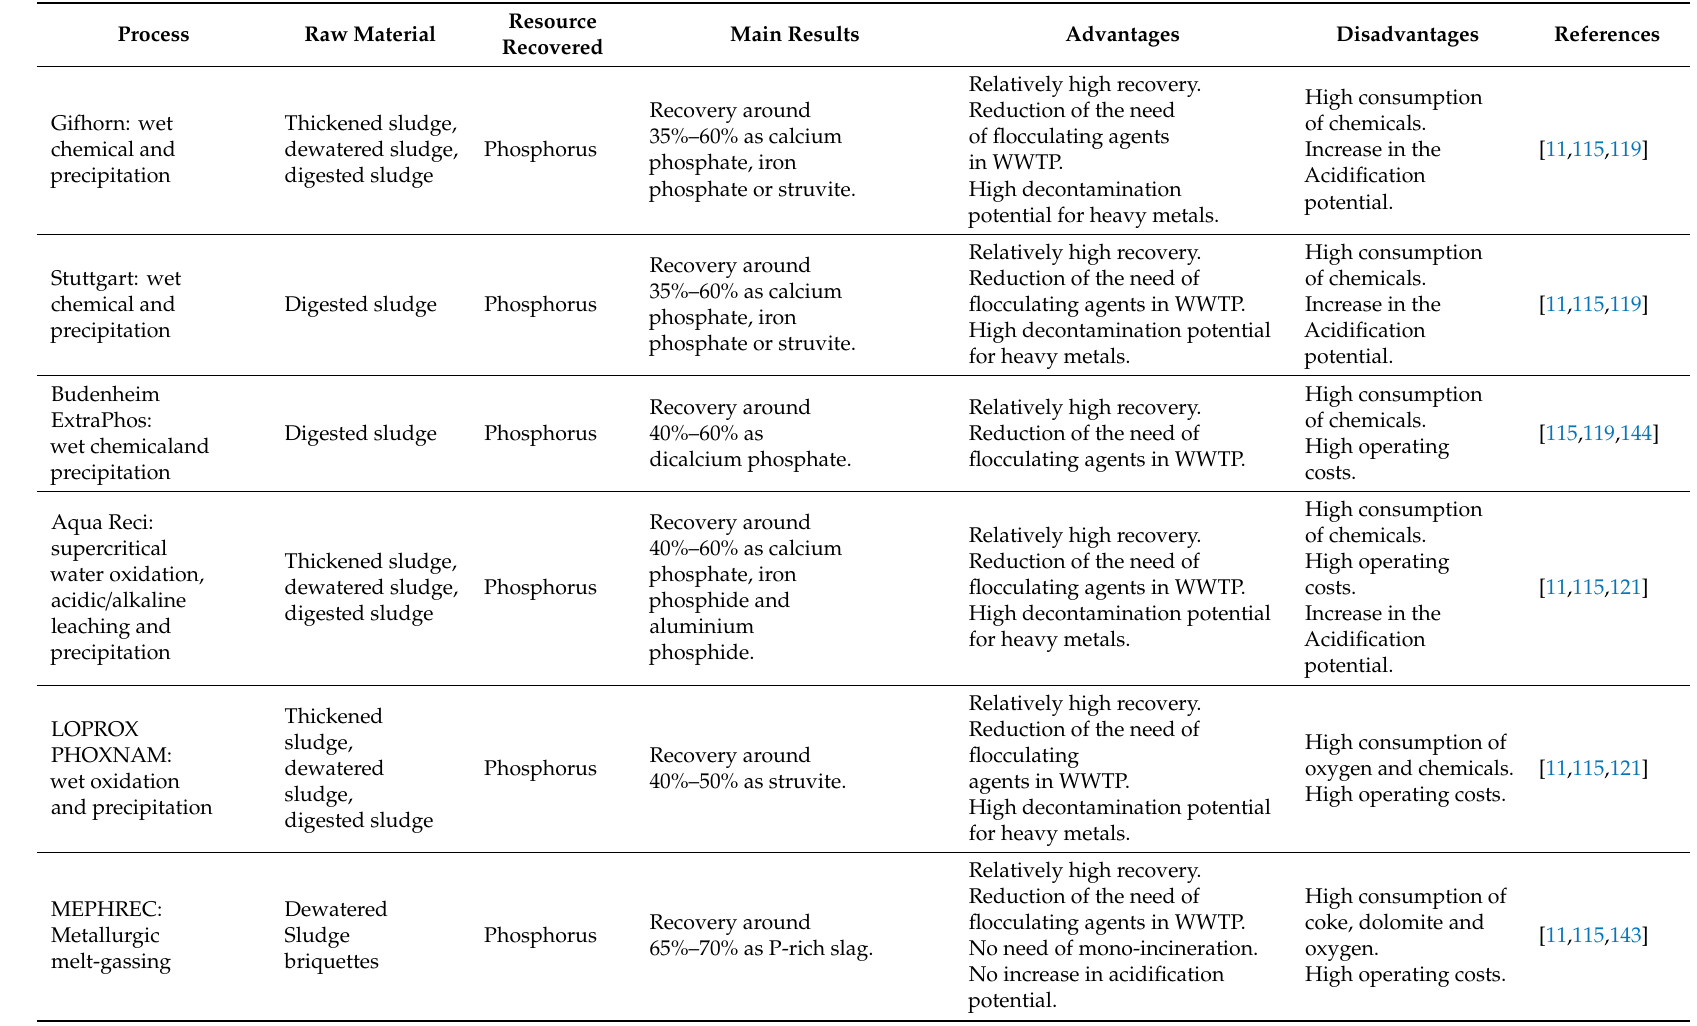
Table 6. Process employed for nutrient recovery from sewage